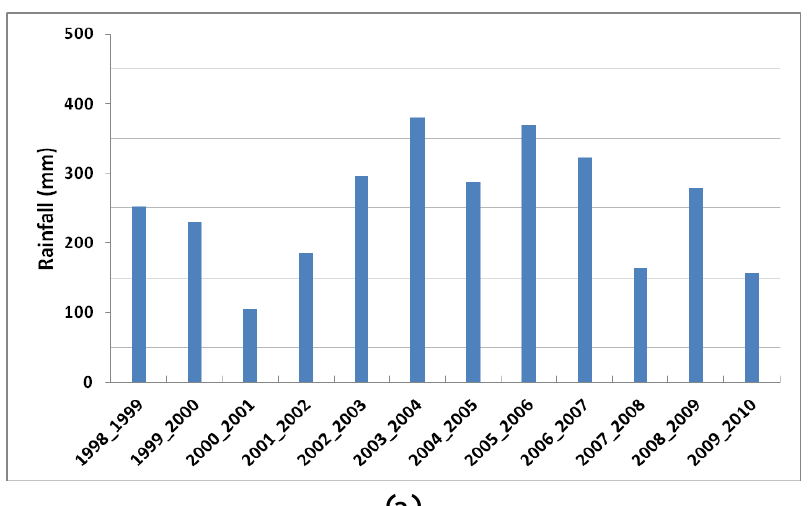
Figure 2. (a) Rainfall variations during the 13-year study period; (b) Annual cycle of monthly